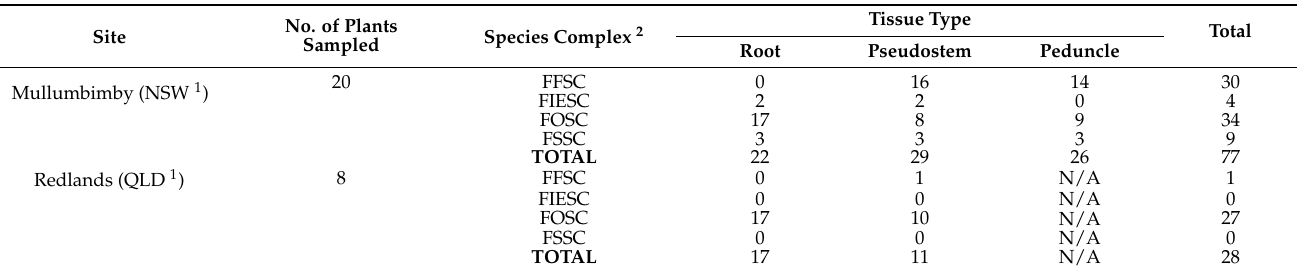
Table 3. Summary of Fusarium species isolated from the tissue of banana plants cultivated at two sites in New South Wales and Queensland,